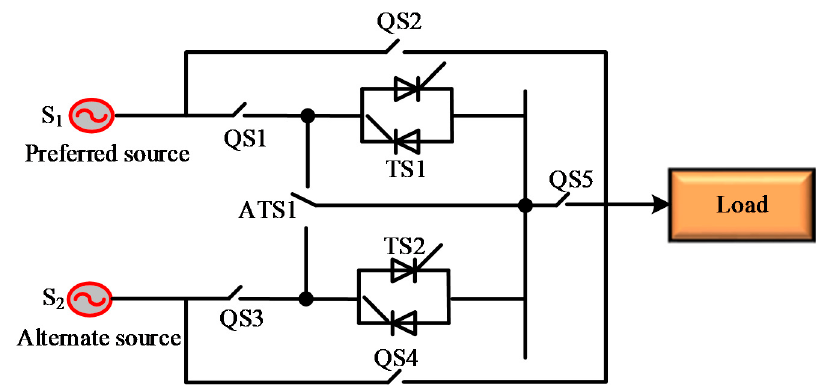
Figure 14. The main circuit structure of HATS [2].